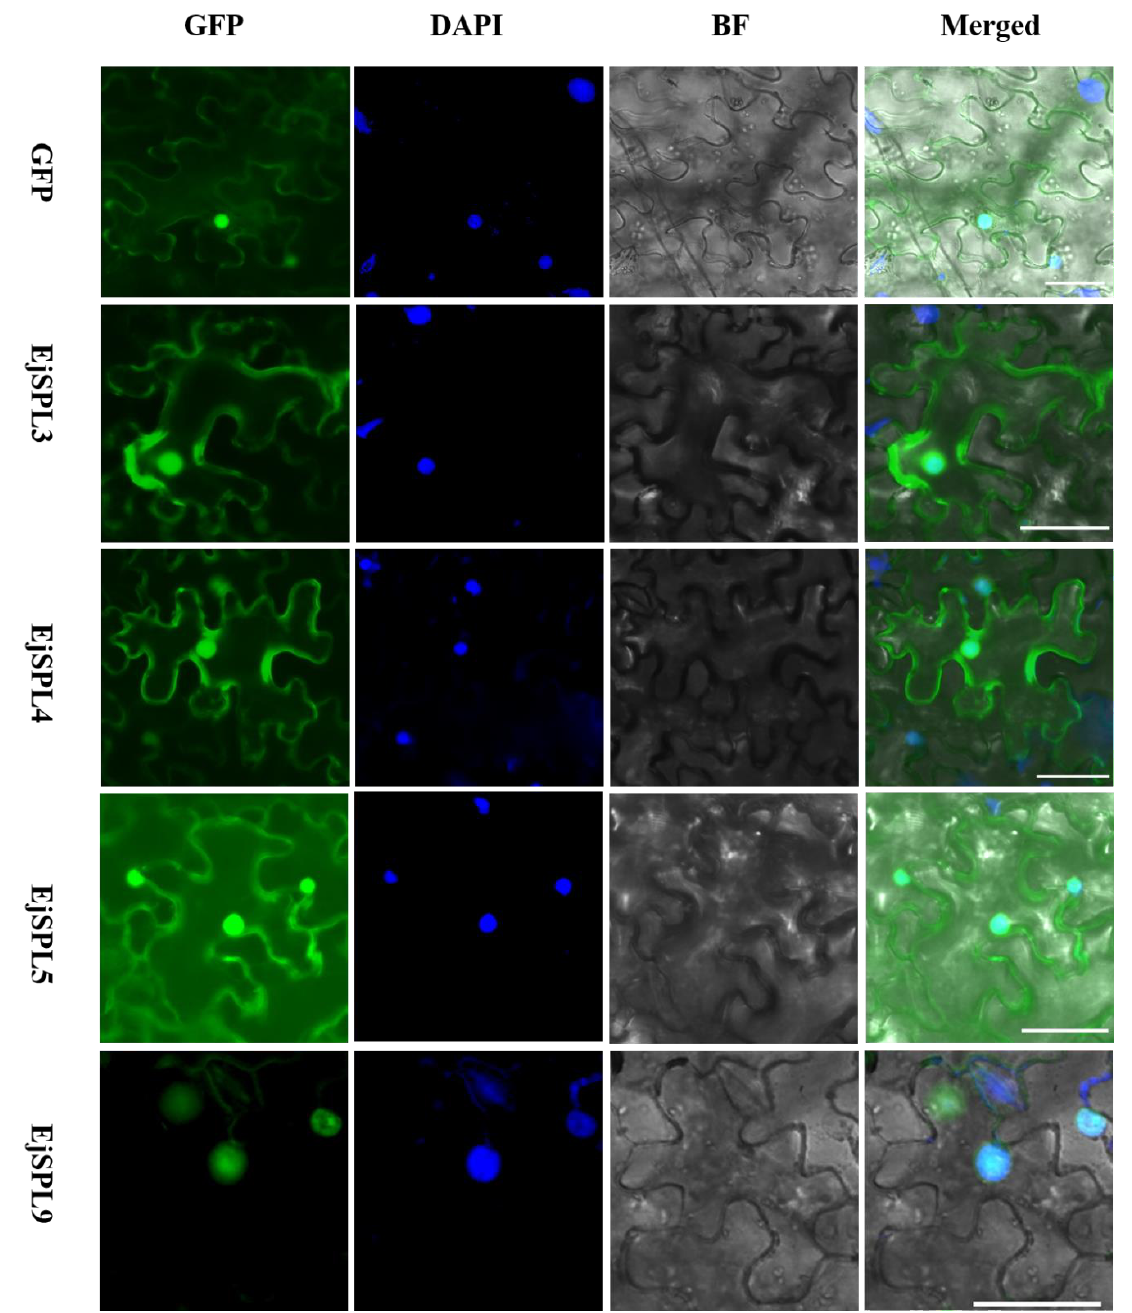
Figure 6. Subcellular localization of EjSPLs in tobacco leaves. GFP, GFP fluorescence channel; 4,6-diamidino-2-phenylindole (DAPI), DAPI fluorescence channel; BF, bright-field; Merged, merged image of GFP, DAPI, and BF. Bars = 50 µm.